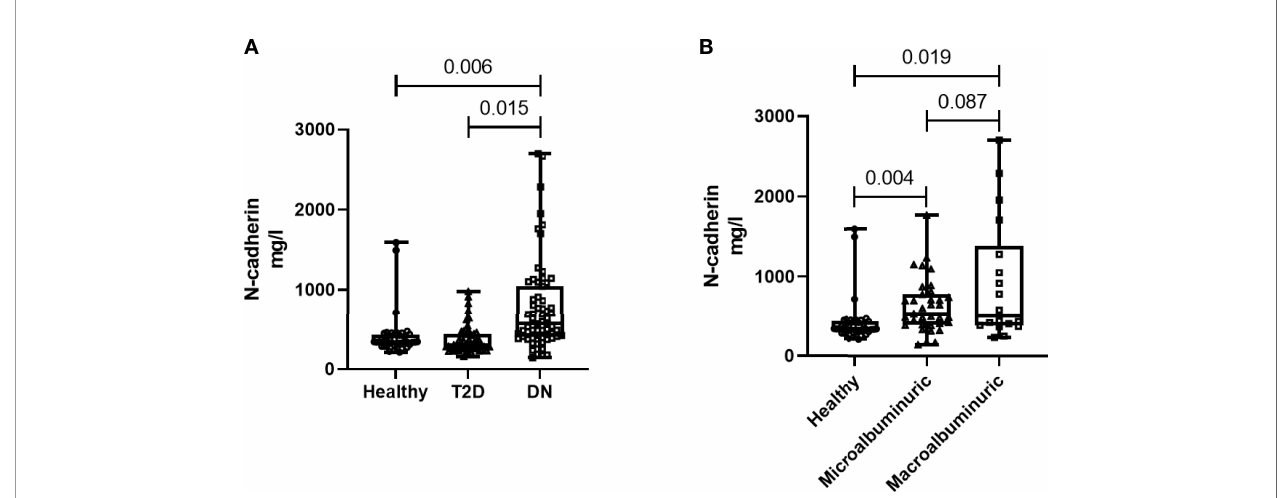
FIGURE 1 | N-cadherin levels in the participants. (A) Based on the diabetes status. (B) Based on the albuminuria levels.